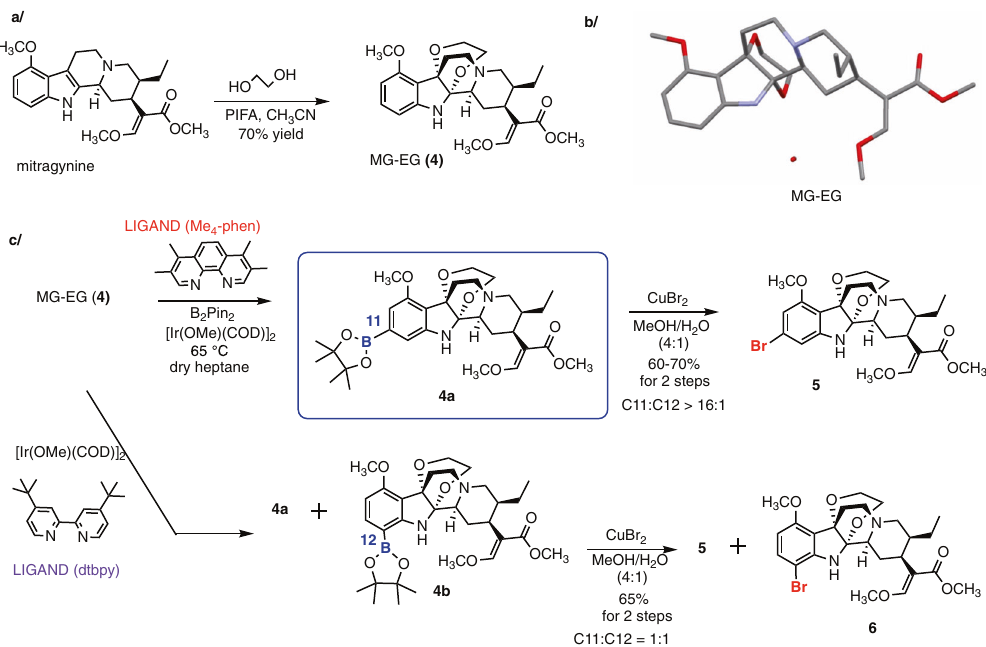
Fig. 4 C11-selective C – H borylation via conversion of MG to mitragynine-ethylene glycol adduct (MG-EG). a One-step synthesis of MG-EG, a stable derivative of MG. b The 3D structure of MG-EG was con fi rmed by X-ray crystallography. ORTEP representation of MG-EG structure is shown without hydrogen atoms for clarity. c C – H borylation of MG-EG gives a mixture of C11- and C12-boronates and the subsequent functionalization products. The high C11 selectivity was achieved by ligand optimization. The ratio was determined by 1 H NMR of crude reaction mixtures. The yields, given as a general range, are based on >20 repetitions by 3 experimenters, on a scale up to 100 mg of substrate.